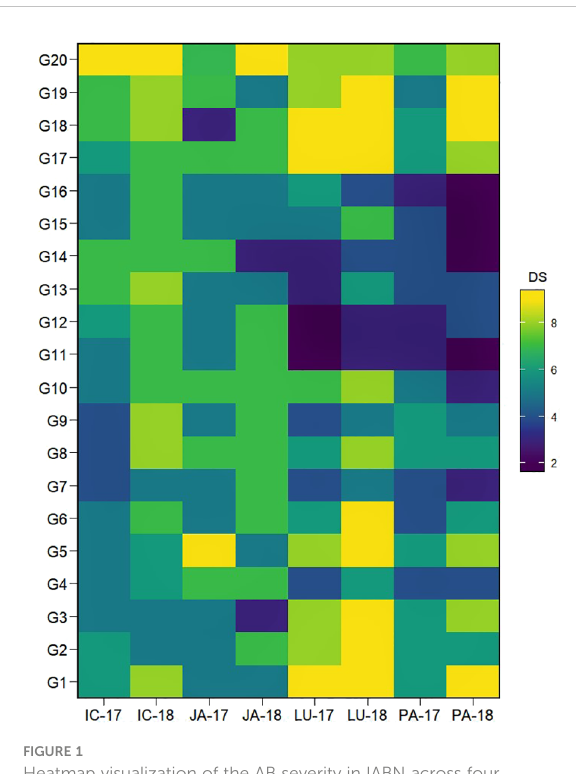
FIGURE 1 Heatmap visualization of the AB severity in IABN across four locations during 2 years. The x-axes show the tested environments. Locations are denoted as IC- (ICRISAT), JA- (Jammu), LU- (Ludhiana), and PA- (Palampur). Years are denoted as -17 (year 2017/ 2018) and -18 (year 2018/2019). The y-axes show the tested genotypes. The plot legend DS or disease severity depicts the 1 – 9 scale for AB severity rating in color. AB, Ascochyta blight; IABN, International Ascochyta Blight